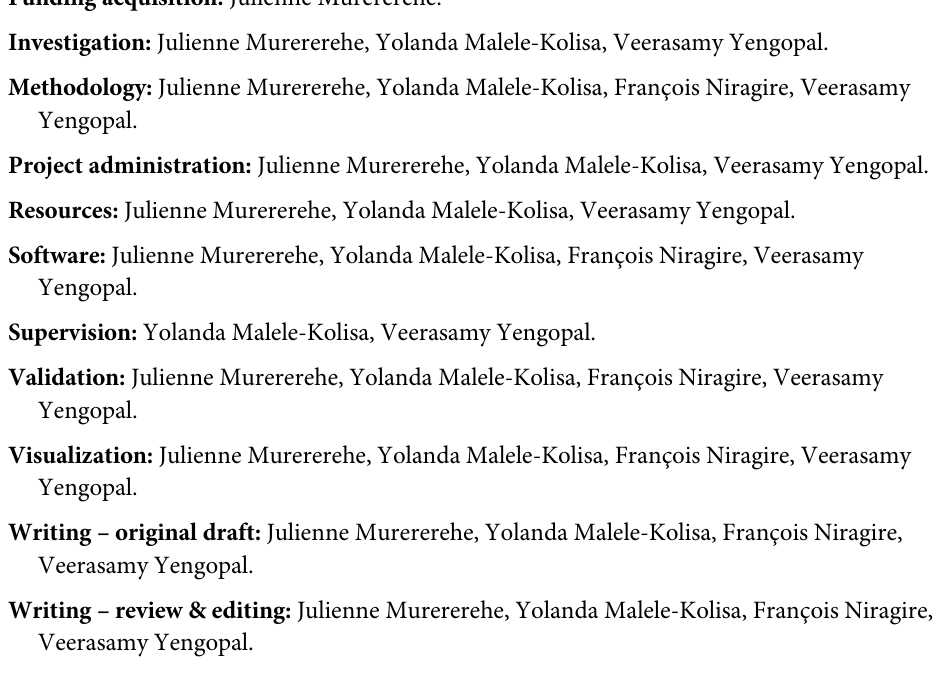
S1 Table. Description of participants’ behaviors factors. S2 Table. Description of other underlying conditions reported by